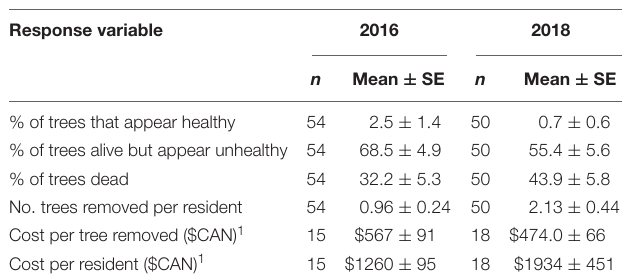
TABLE 4 | Impact of Orchestes fagi on American beech on residential properties in Halifax Regional Municipality, as determined by resident surveys and site visits in fall of 2016 and 2018.